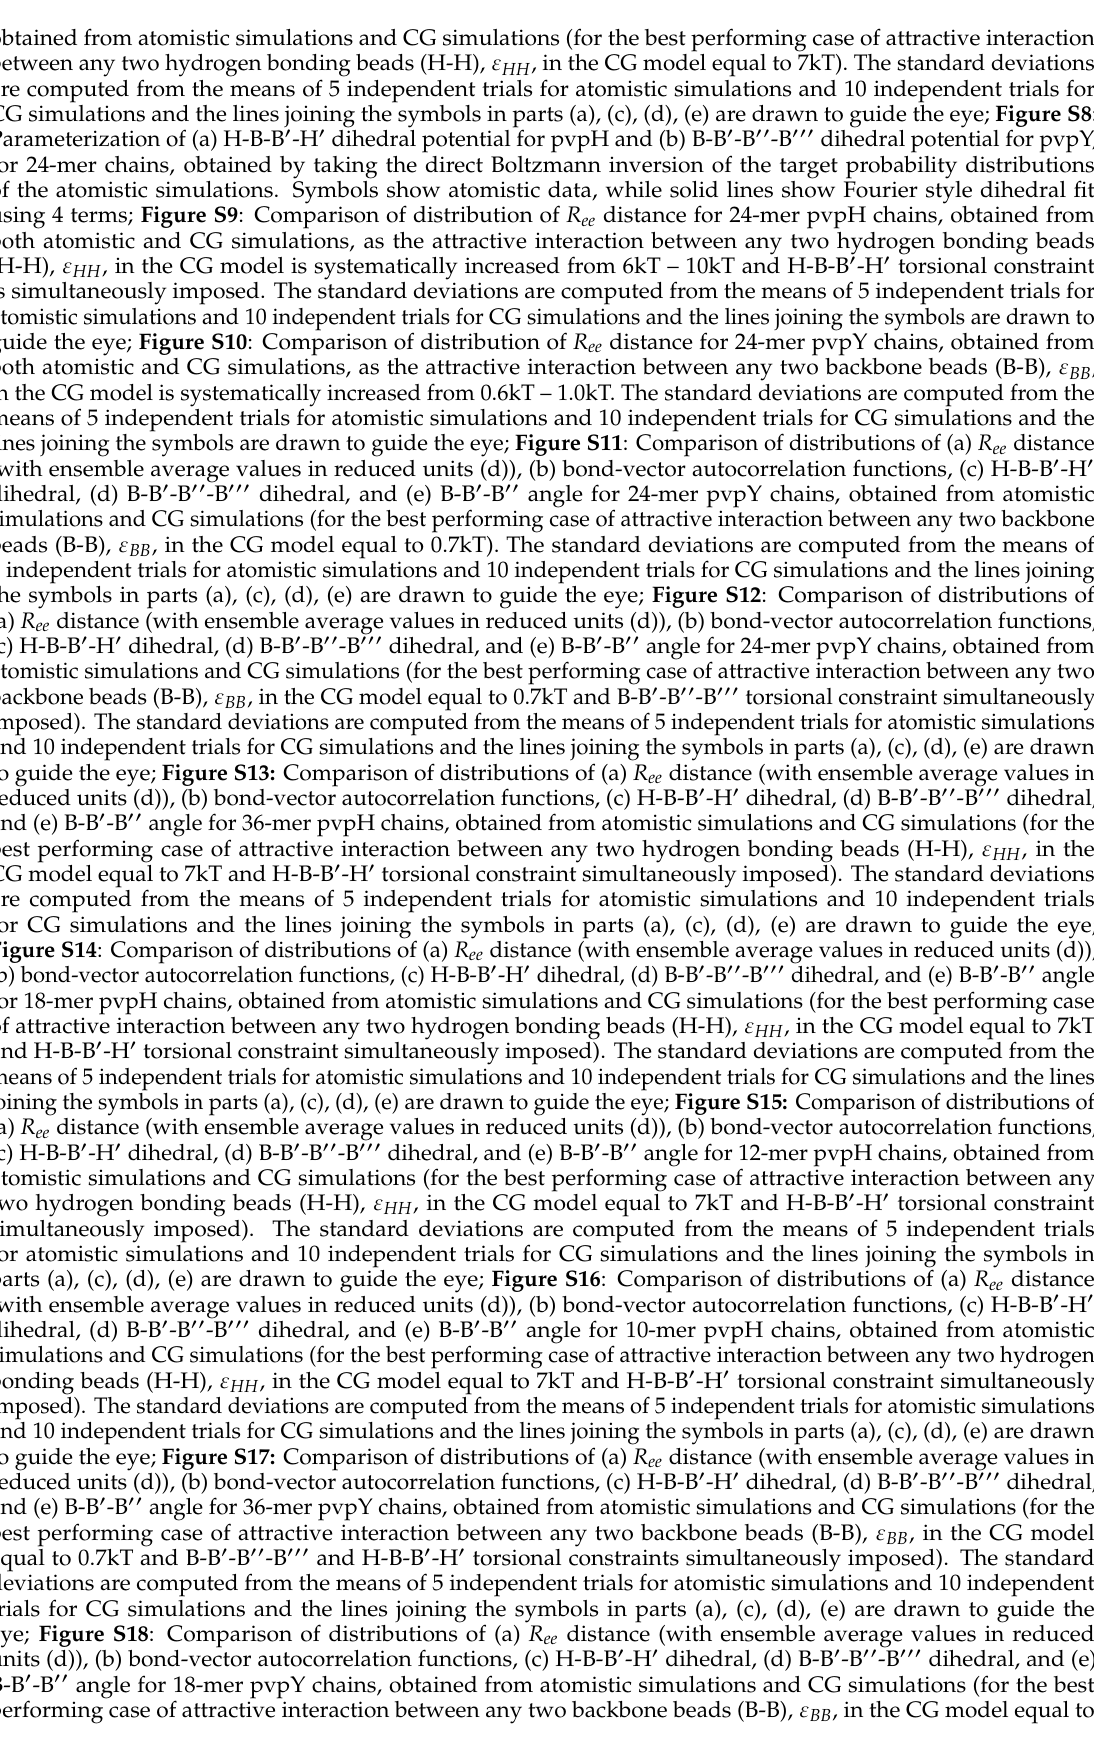
and 10 independent trials for CG simulations and the lines joining the symbols in parts (a), (c), (d), (e) are drawn to guide the eye; Figure S17: Comparison of distributions of (a) R ee distance (with ensemble average values in reduced units (d)), (b) bond-vector autocorrelation functions, (c) H-B-B (cid:48) -H (cid:48) dihedral, (d) B-B (cid:48) -B (cid:48)(cid:48) -B (cid:48)(cid:48)(cid:48) dihedral, and (e) B-B (cid:48) -B (cid:48)(cid:48) angle for 36-mer pvpY chains, obtained from atomistic simulations and CG simulations (for the best performing case of attractive interaction between any two backbone beads (B-B), ε BB , in the CG model equal to 0.7kT and B-B (cid:48) -B (cid:48)(cid:48) -B (cid:48)(cid:48)(cid:48) and H-B-B (cid:48) -H (cid:48) torsional constraints simultaneously imposed). The standard deviations are computed from the means of 5 independent trials for atomistic simulations and 10 independent trials for CG simulations and the lines joining the symbols in parts (a), (c), (d), (e) are drawn to guide the eye; Figure S18 : Comparison of distributions of (a) R ee distance (with ensemble average values in reduced units (d)), (b) bond-vector autocorrelation functions, (c) H-B-B (cid:48) -H (cid:48) dihedral, (d) B-B (cid:48) -B (cid:48)(cid:48) -B (cid:48)(cid:48)(cid:48) dihedral, and (e) B-B (cid:48) -B (cid:48)(cid:48) angle for 18-mer pvpY chains, obtained from atomistic simulations and CG simulations (for the